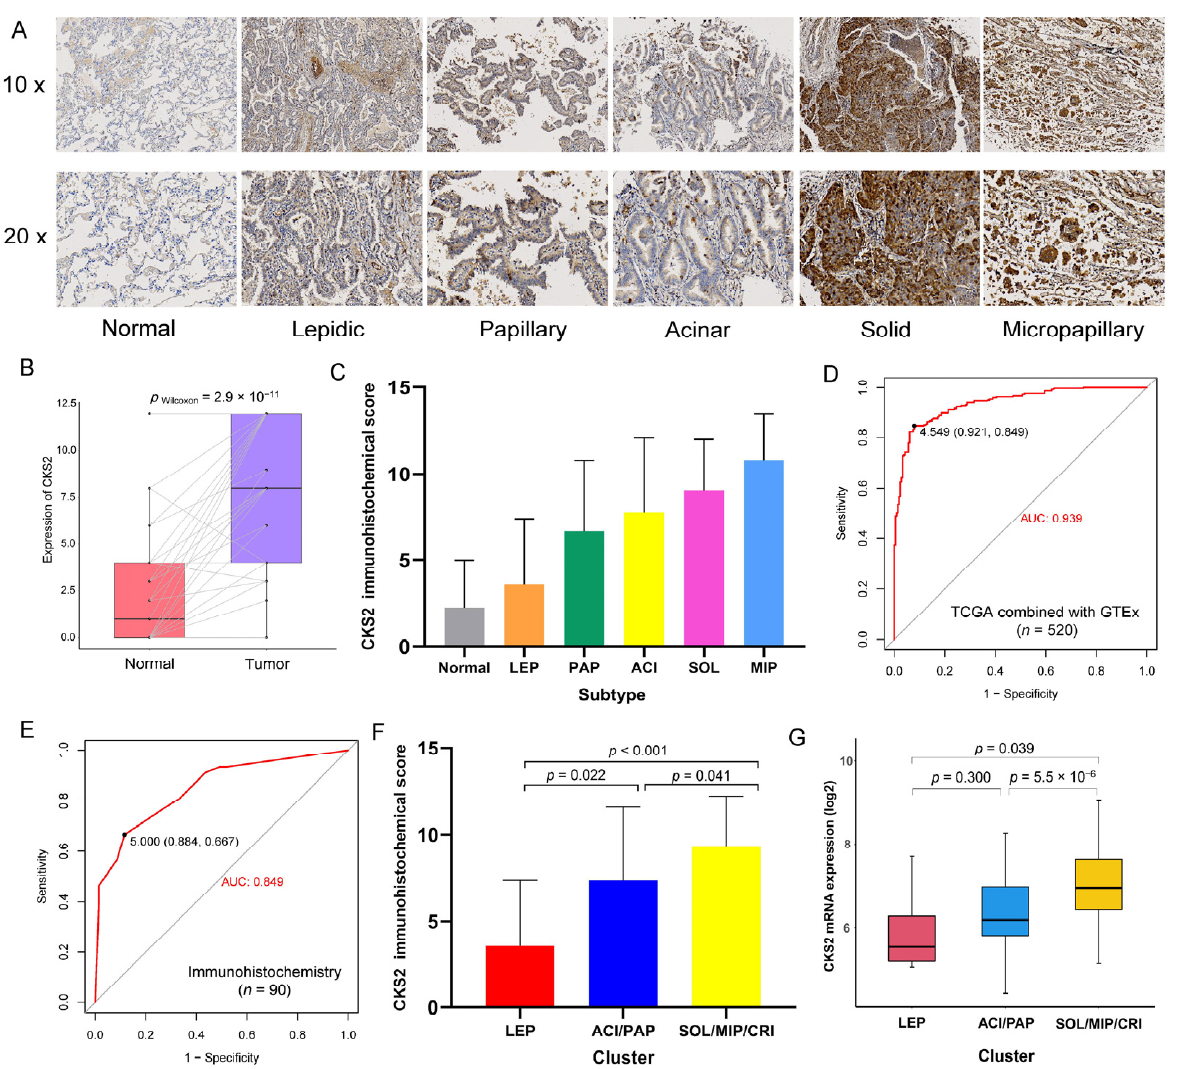
Figure 1. The expression of CKS2 and various histological subtypes in stages I–III invasive non- mucinous lung adenocarcinoma. ( A ) Representative immunohistochemical staining plots for CKS2 in different histological subtypes. ( B ) The difference in CKS2 immunohistochemical scores between 69 pairs of adjacent normal lung and tumor tissues among 90 cases from the local hospital. ( C ) Box plot of the CKS2 immunohistochemical scores ( n = 90) in different histological subtypes. ( D ) ROC plot of CKS2 mRNA expression predicting LUAD tumorigenesis using TCGA combined with GTEx dataset (training cohort, n = 520, AUC value = 0.939). ( E ) ROC plot of CKS2 immunohistochemical scores predicting LUAD tumorigenesis (validation cohort, n = 90, AUC value = 0.849). ( F ) Box plot of CKS2 immunohistochemical scores ( n = 90) in different histological subtypes clusters. ( G ) Box plot of CKS2 mRNA expression levels ( n = 211) in different histological subtypes clusters.